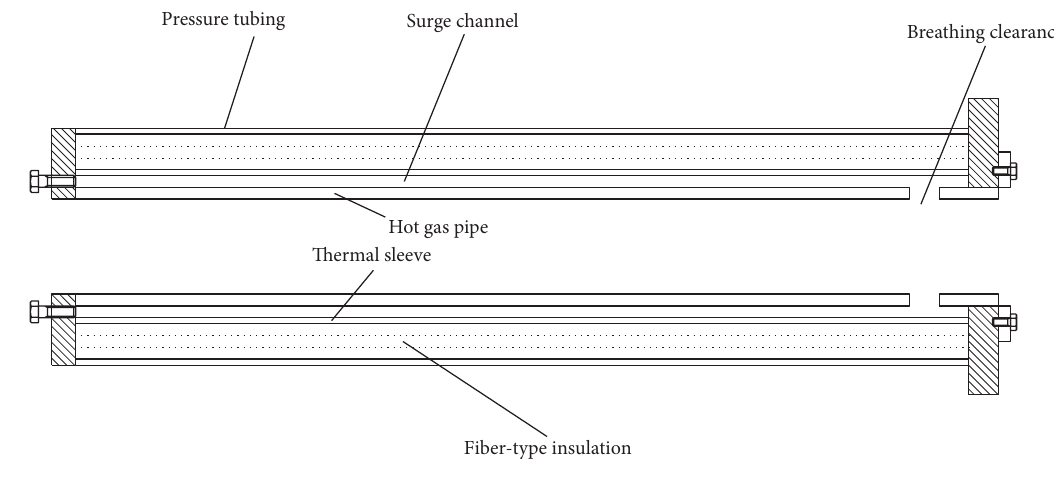
Figure 1: Schematic structure of hot gas